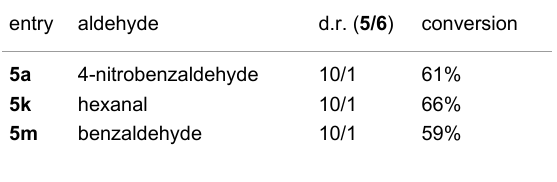
Table 3: Prins fluorination reaction with alcohol 3 and aldehydes at − 20 °C. Reaction conditions: BF 3 ·OEt 2 (1 equiv), but-3-en-1-ol ( 3 )